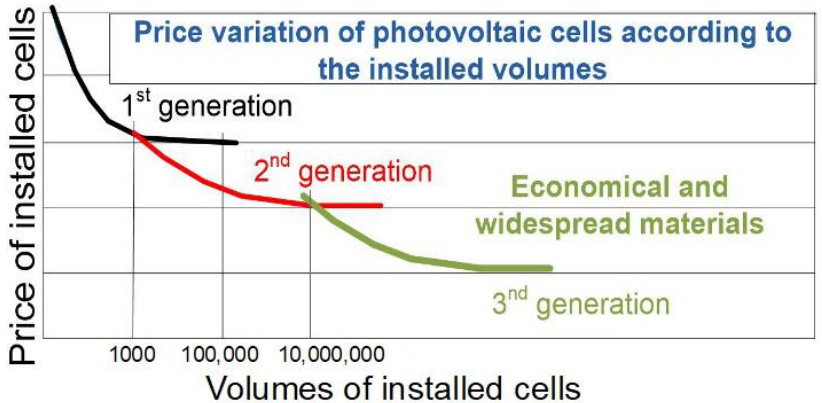
Figure 4. Cost reduction for the third generation PV.